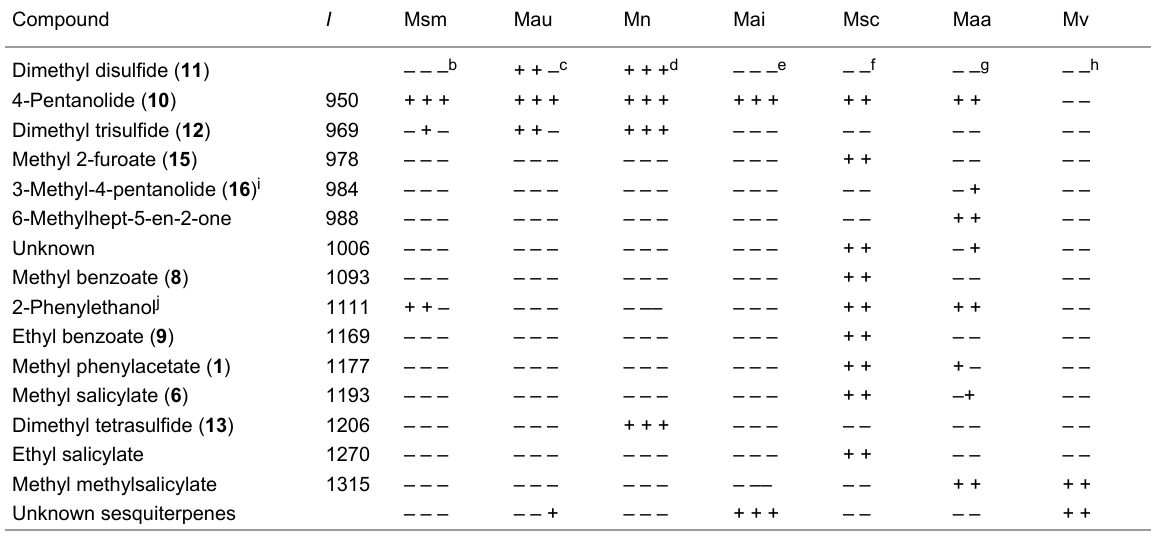
Table 2: Volatiles released by diverse nontuberculous mycobacteria grown on a 7H11 solid medium. a